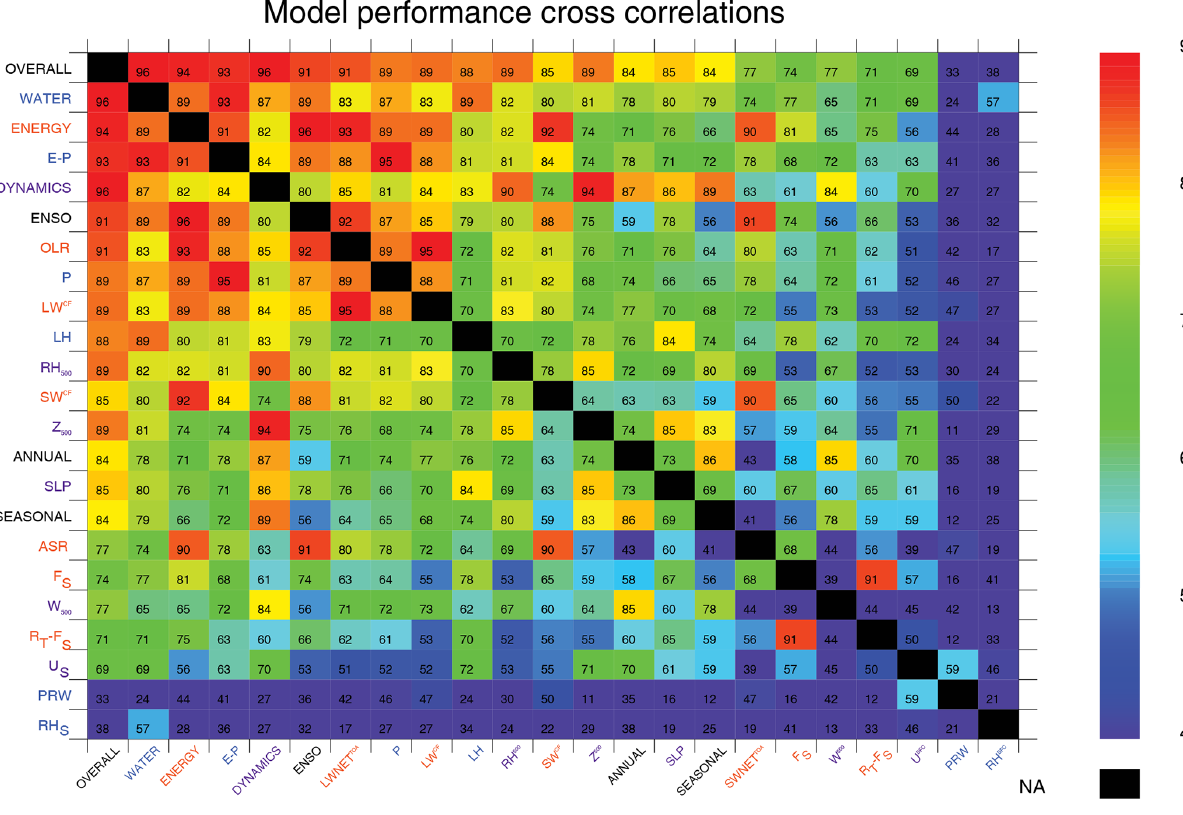
Figure 5. Cross correlations between variable and aggregate scores computed for the all CMIP archives sorted in order of decreasing correlations from left to right and top to